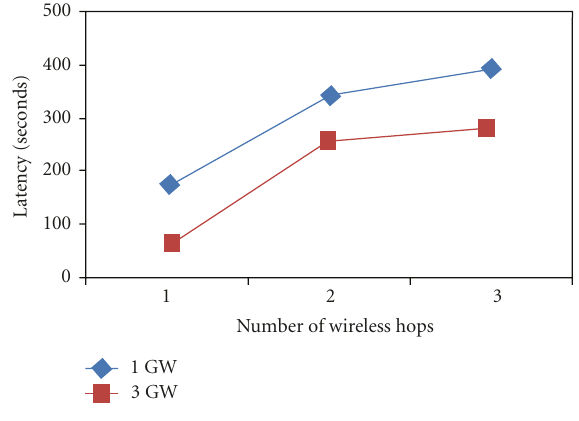
Figure 15: E ff ect of WSN topology